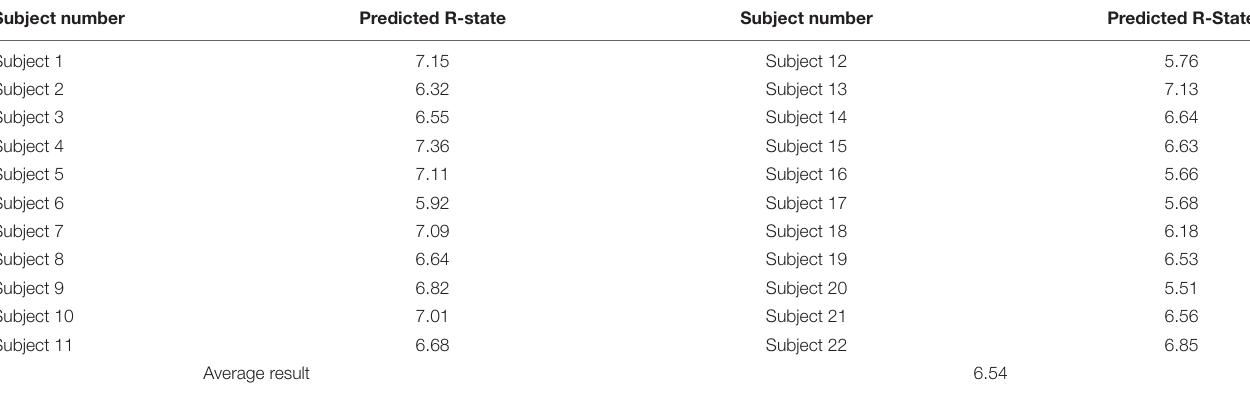
TABLE 9 | Predicted R-state of each